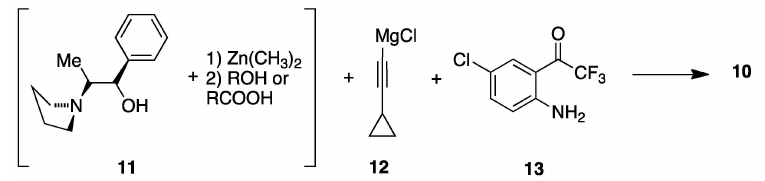
Scheme 4. Chen enatioselective synthesis of 10